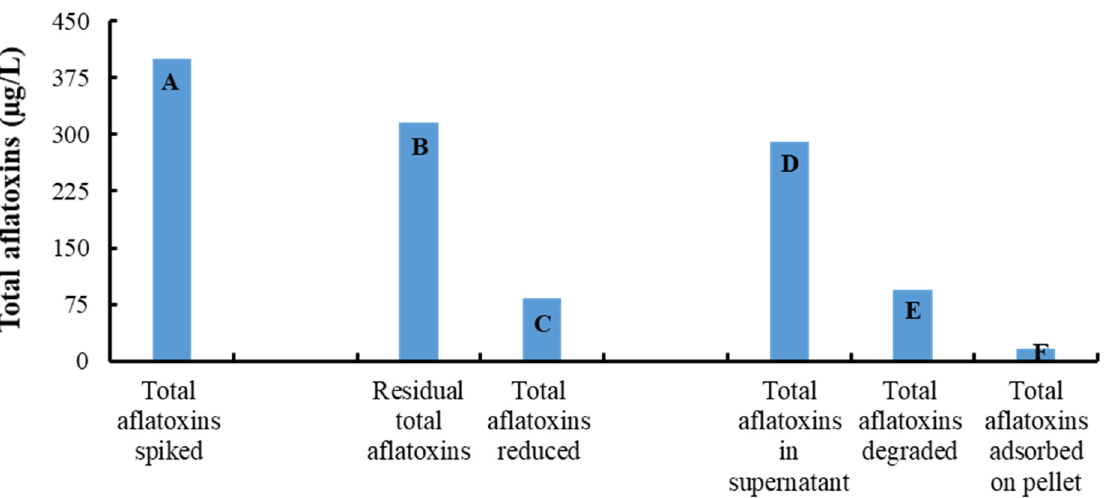
Figure 5. Degradation of aflatoxin (100 µg/kg each of aflatoxins B1, G1, B2, and G2) by the microbial consortium obtained from doenjang . The bar column (A) represents the amount of total aflatoxins spiked. The bar columns (B) and (C) represent total residual aflatoxin (B) and the corresponding amount of the reduced aflatoxin (C), respectively, after 5 days of incubation. The bar columns (D), (E), and (F) represent total aflatoxin in the cell-free supernatant (D), degraded aflatoxin (E), and aflatoxin adsorbed by the microbial consortium obtained from doenjang (F), respectively.